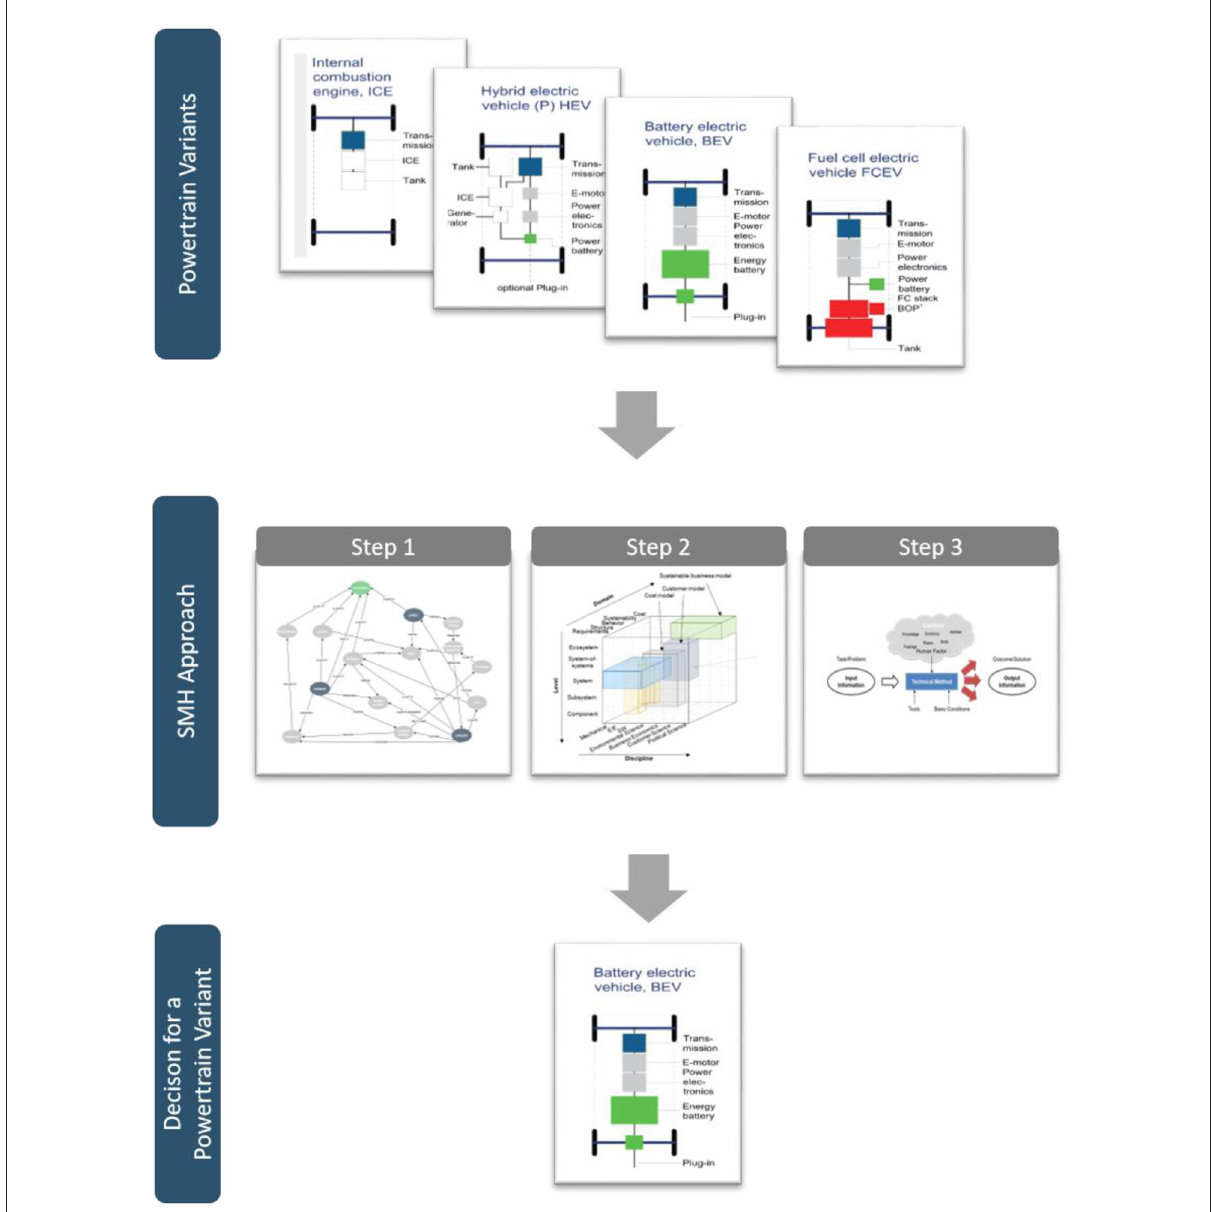
FIGURE1 Generic illustration of the SMH approach to support decision-making in the context of powertrain development, inspired by Kranabitl et al.